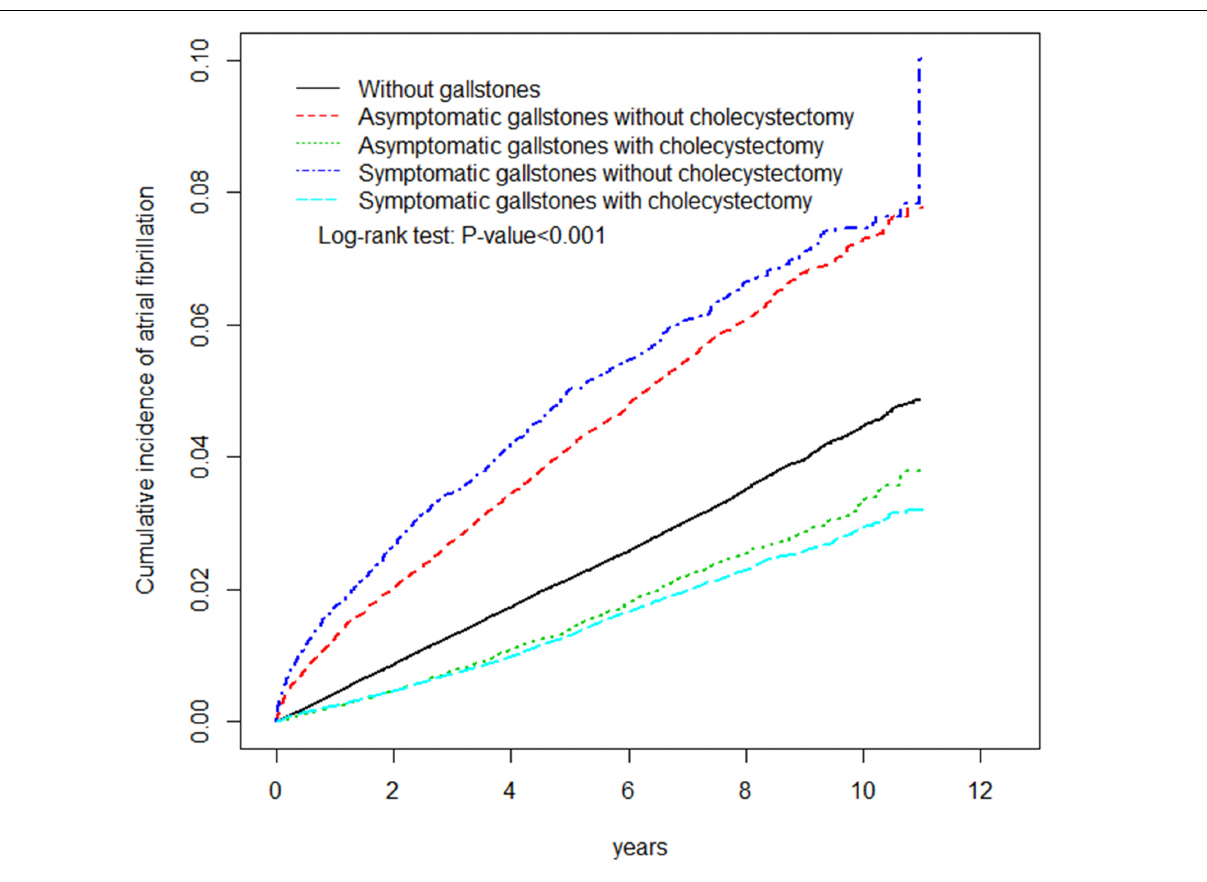
FIGURE 2 | The adjusted cumulative incidence curves of atrial fibrillation between patients with or without gallstone